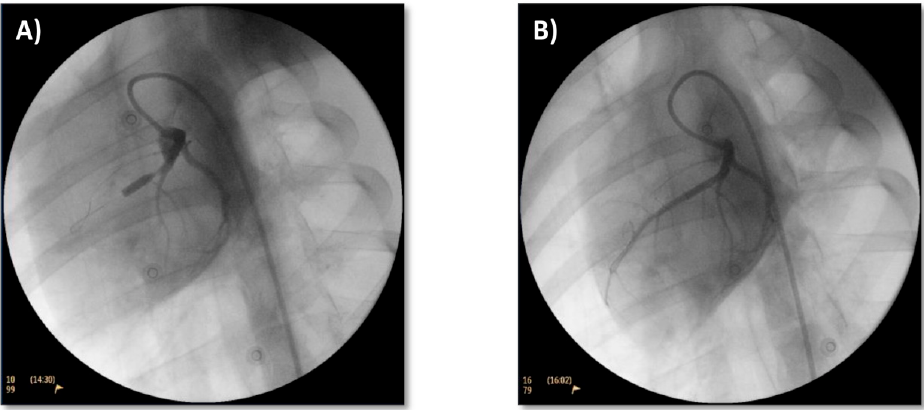
Figure 2. Coronary angiograms. Coronary angiograms in 40° LAO projection to assess proper occlusion of the vessel immediately distal to the first diagonal branch of paraconal interventricular artery ( A ) and vessel patency after removal of angioplasty balloon ( B ).